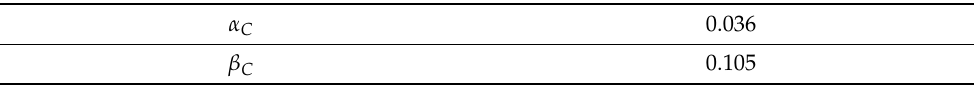
Table 1. Energy and investment share factor.